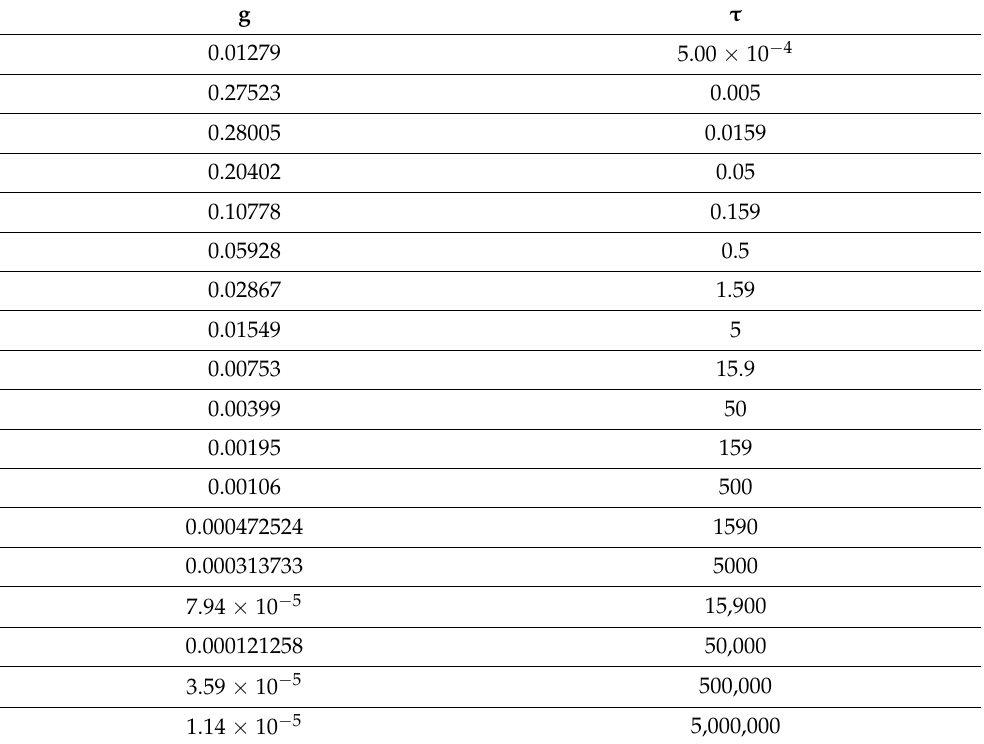
Table 7. Prony series coefficients of HECM.